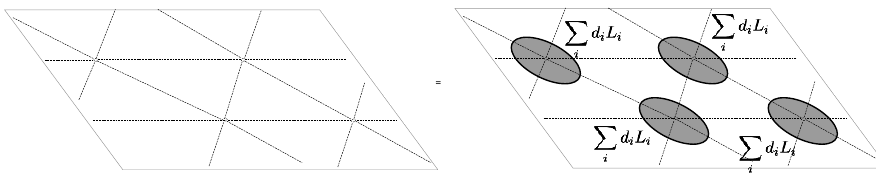
Figure 36 . The Hilbert space associated to a surface (cid:6) without holes (left) can be embedded in the Hilbert space associated to a surface (cid:6) 0 with holes (right), as the image of projectors de(cid:12)ned by the action of closed boundary lines P d i L i . i